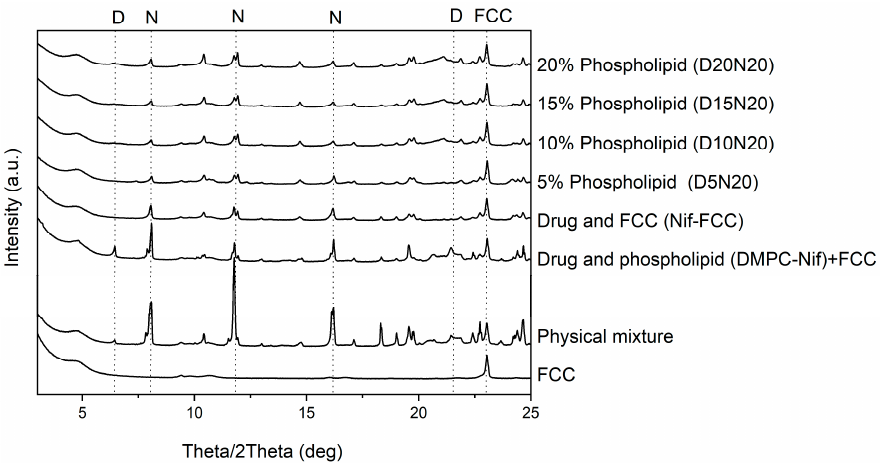
Figure 7. XRPD results of the formulations and physical mixture. The model drug was present in partial crystalline form in all formulations. The reference peaks of nifedipine (N) (8.11°, 11.76°, and 16.16°) and 1,2-dimyristoyl-sn-glycero-3-phosphocholine (DMPC) (D) (6.65° and 20.98°) are marked with dashed lines. A reference peak for FCC at 23.01° is also marked. The sample DMPC-Nif was physically mixed with FCC to keep the ratio of the components constant for all samples.